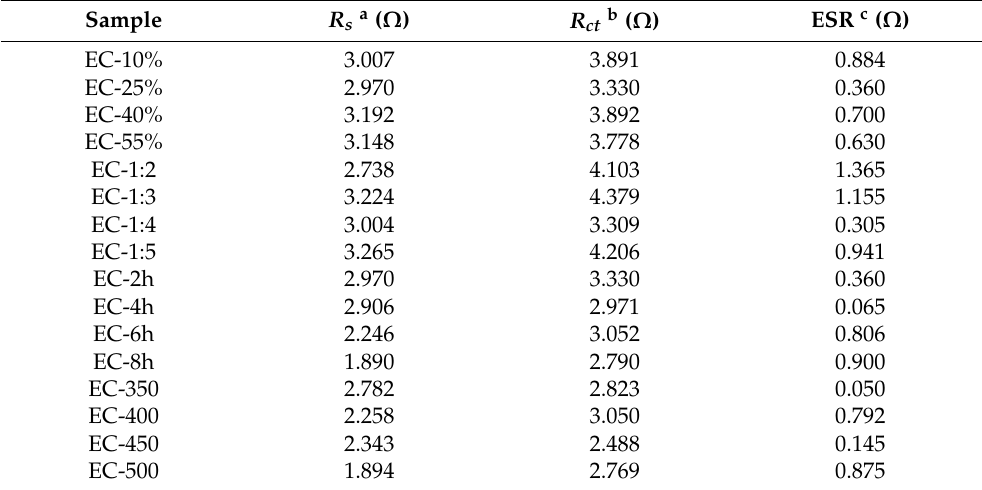
Figure 6. ( a – d ) The EIS curves of ECs. Table 4. Parameters for samples obtained from electrochemical impedance spectroscopy